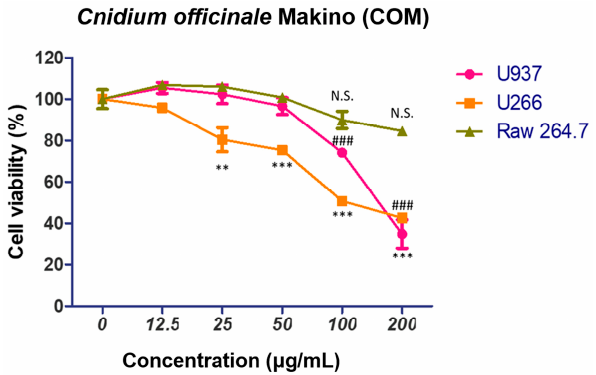
Figure 1. Cytotoxic effect of Cnidium officinale Makino in U937 and U266 cells. U266 and U937 cells and murine macrophage cell lines Raw264.7 were seeded onto 96-well microplates at a density of 2 × 10 4 cells/well and treated with various concentrations of COM (0, 12.5, 25, 50, 100 or 200 µg/mL) for 24 h. Cell viability was determined by EZ-cytox Enhanced cell viability assay kit. Values represent the means of three experiments ± SD; ** p < 0.01, *** p < 0.001 versus untreated control of U266; ### p < 0.001 versus untreated control of U937. N.S. means not significant.